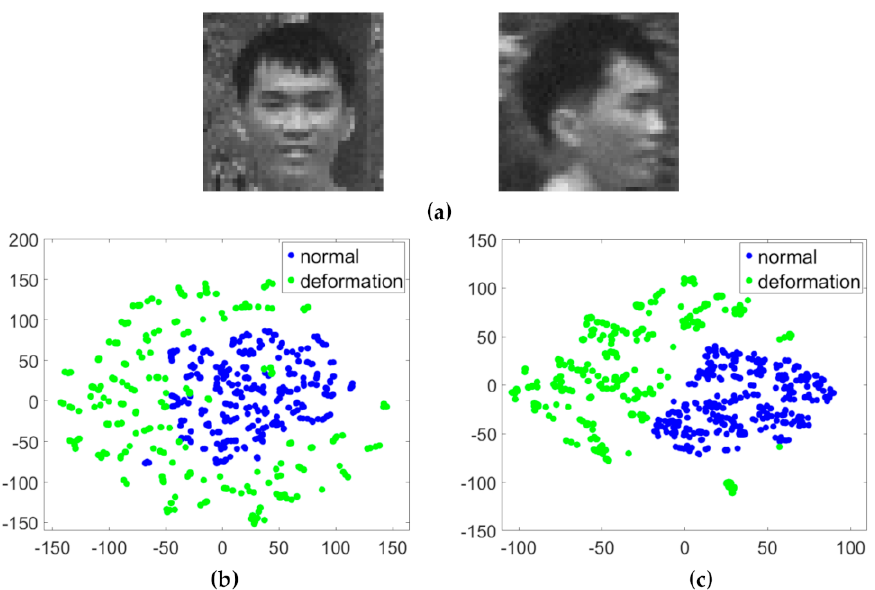
Figure 5. The scatter-plot visualization representations of the HSI and RGB datasets with the challenge of deformation using t-SNE. ( a ) Sample images of the dataset with deformation (normal and deformation). The target deforms as the face moves. ( b ) Visualization of the HSI dataset. ( c ) Visualization of the RGB dataset. The x axis and y axis represent the two feature values of the data in two-dimensional space, respectively. There are two states (normal and deformation) of the same object in two datasets, each of which is represented a particular